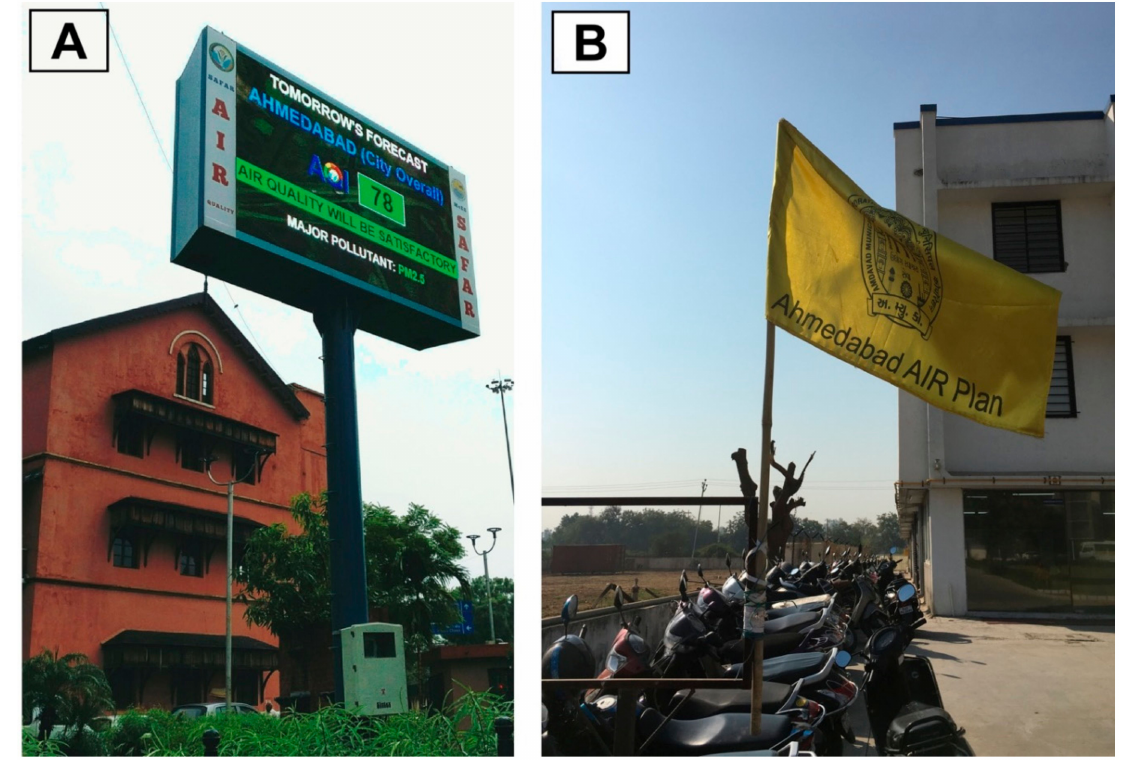
Figure 3. ( A ) Digital display board of IITM-SAFAR forecast city-wide AQI (one of 12 in Ahmedabad), and ( B ) A yellow flag at Zebar School for Children indicates an IITM-SAFAR AQI forecast of Moderate air quality (yellow category, AQI 101-200) for the coming